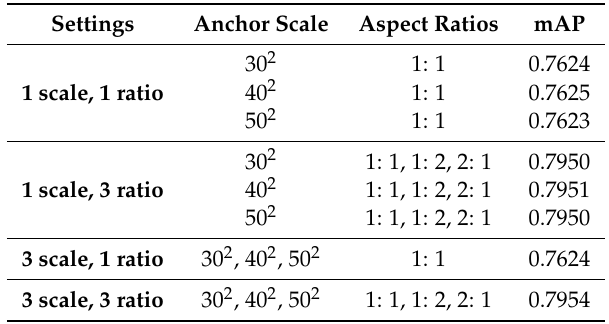
Table 1. The mean average precision (mAP) under different scales and aspect ratios of anchors. Settings Anchor Scale Aspect Ratios mAP 30 2 1: 1 0.7624